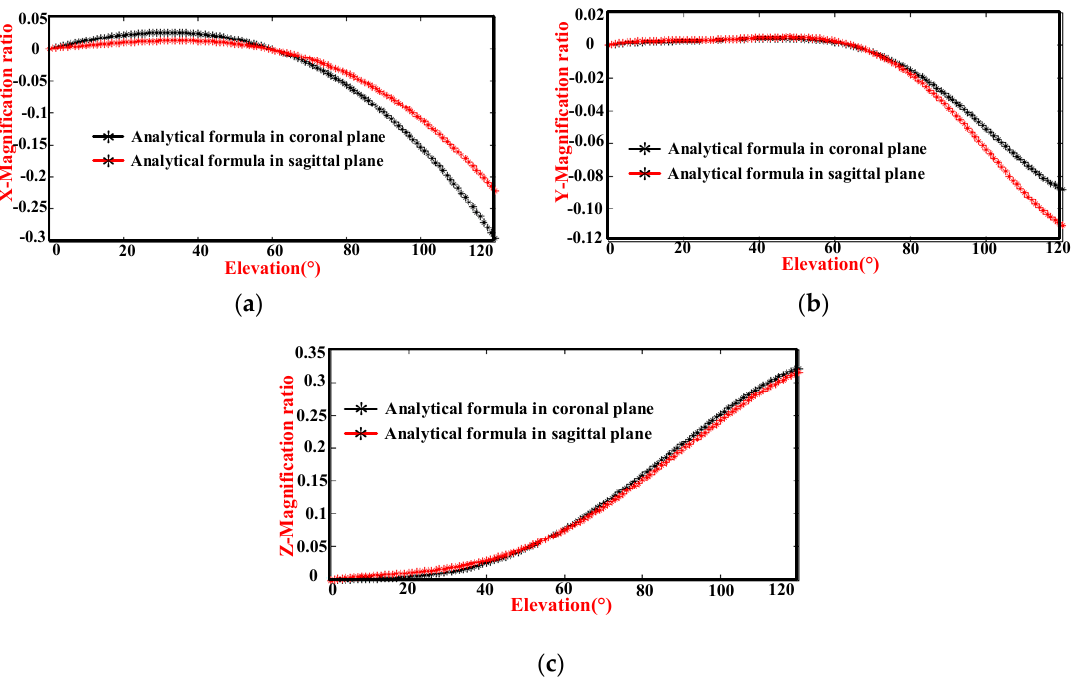
Figure 13. Comparison of the magnification ratio of the GH joint center displacement variable quantity relative to the thorax coordinate system during humeral elevation in the coronal and sagittal planes: ( a ) X-direction magnification ratio and humeral elevation angle, ( b ) Y-direction magnification ratio and humeral elevation angle, and ( c ) Z-direction magnification ratio and humeral elevation angle.